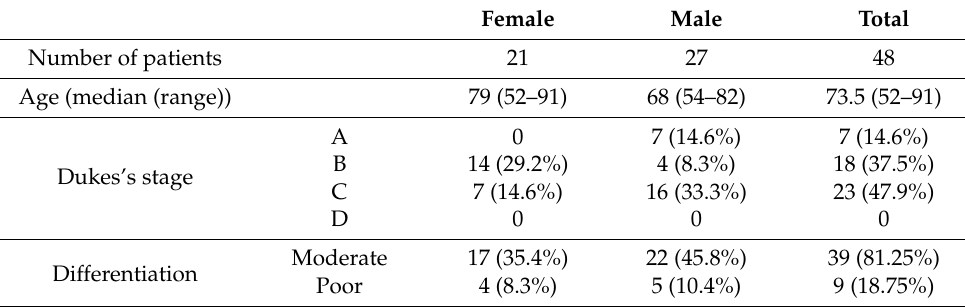
Table 1. Patient demographics and tumour